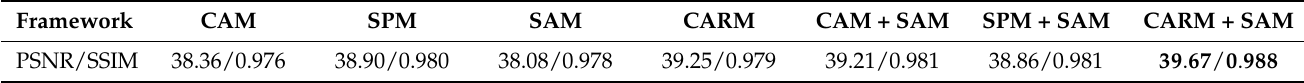
Table 3. Ablation study on analysis of the proposed SCAM.